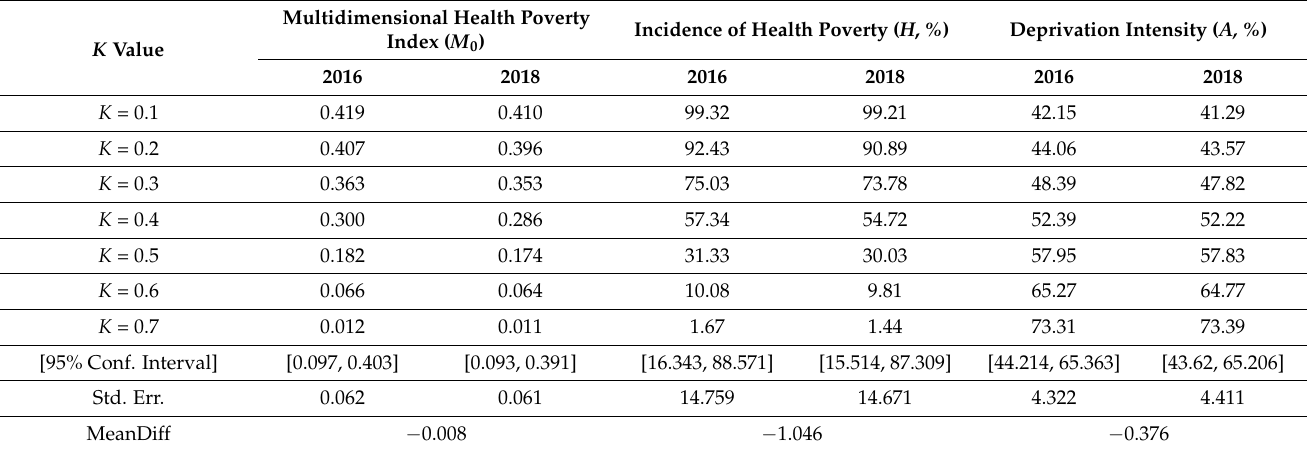
Table 4. Multidimensional health poverty index under different